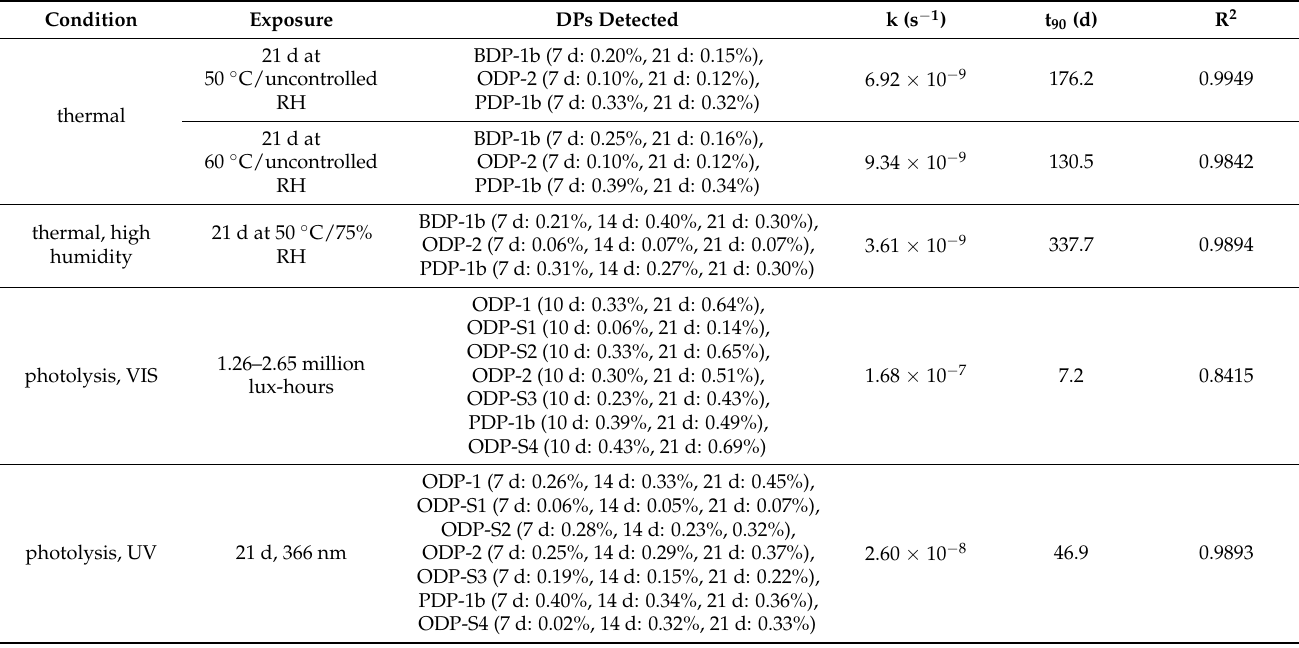
Table 4. Results of solid-state degradation of